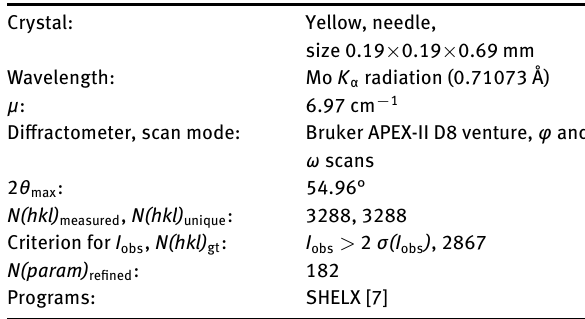
Table 2: Fractional atomic coordinates and isotropic or